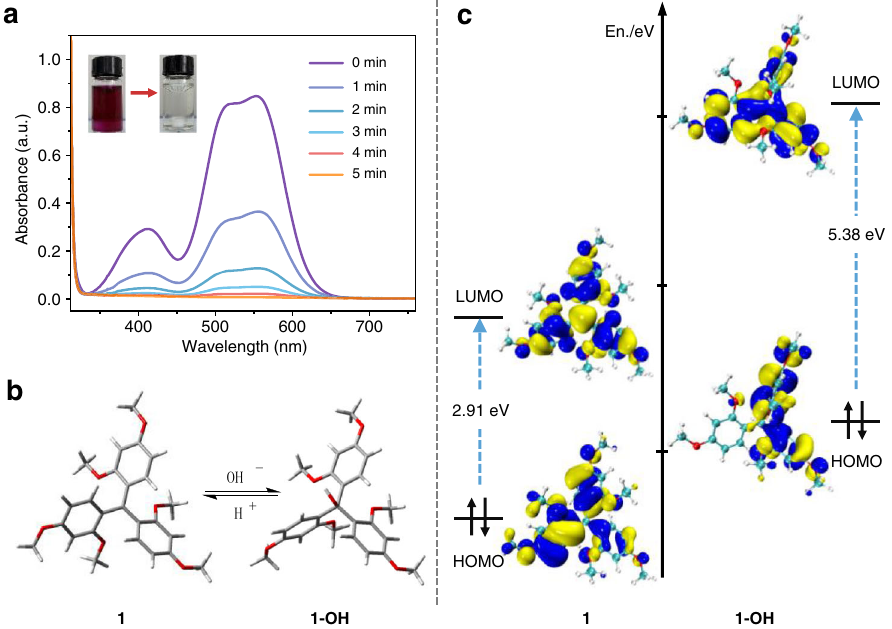
Fig. 7 Decoloration of the OPC 1 and proposed mechanism of decoloration. a UV/vis absorption spectrum of the polymerization mixture after addition of triethylamine, inset showing the corresponding apparent color change of the mixture solution. b Optimized chemical conformation of OPC 1 and 1-OH and their transition mechanism (DFT, B3LYP/6 – 31 G*). c Frontier orbitals, energy levels and their potential gaps of the ground state of OPC 1 (left) and 1-OH (right) calculated by DFT (B3LYP/6 – 31